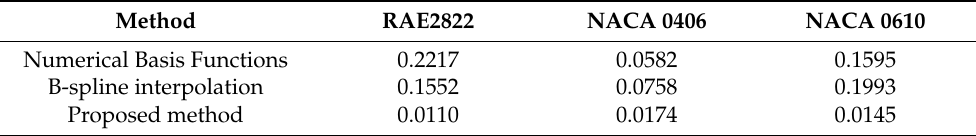
Table 13. Best Approximation of target airfoils for different